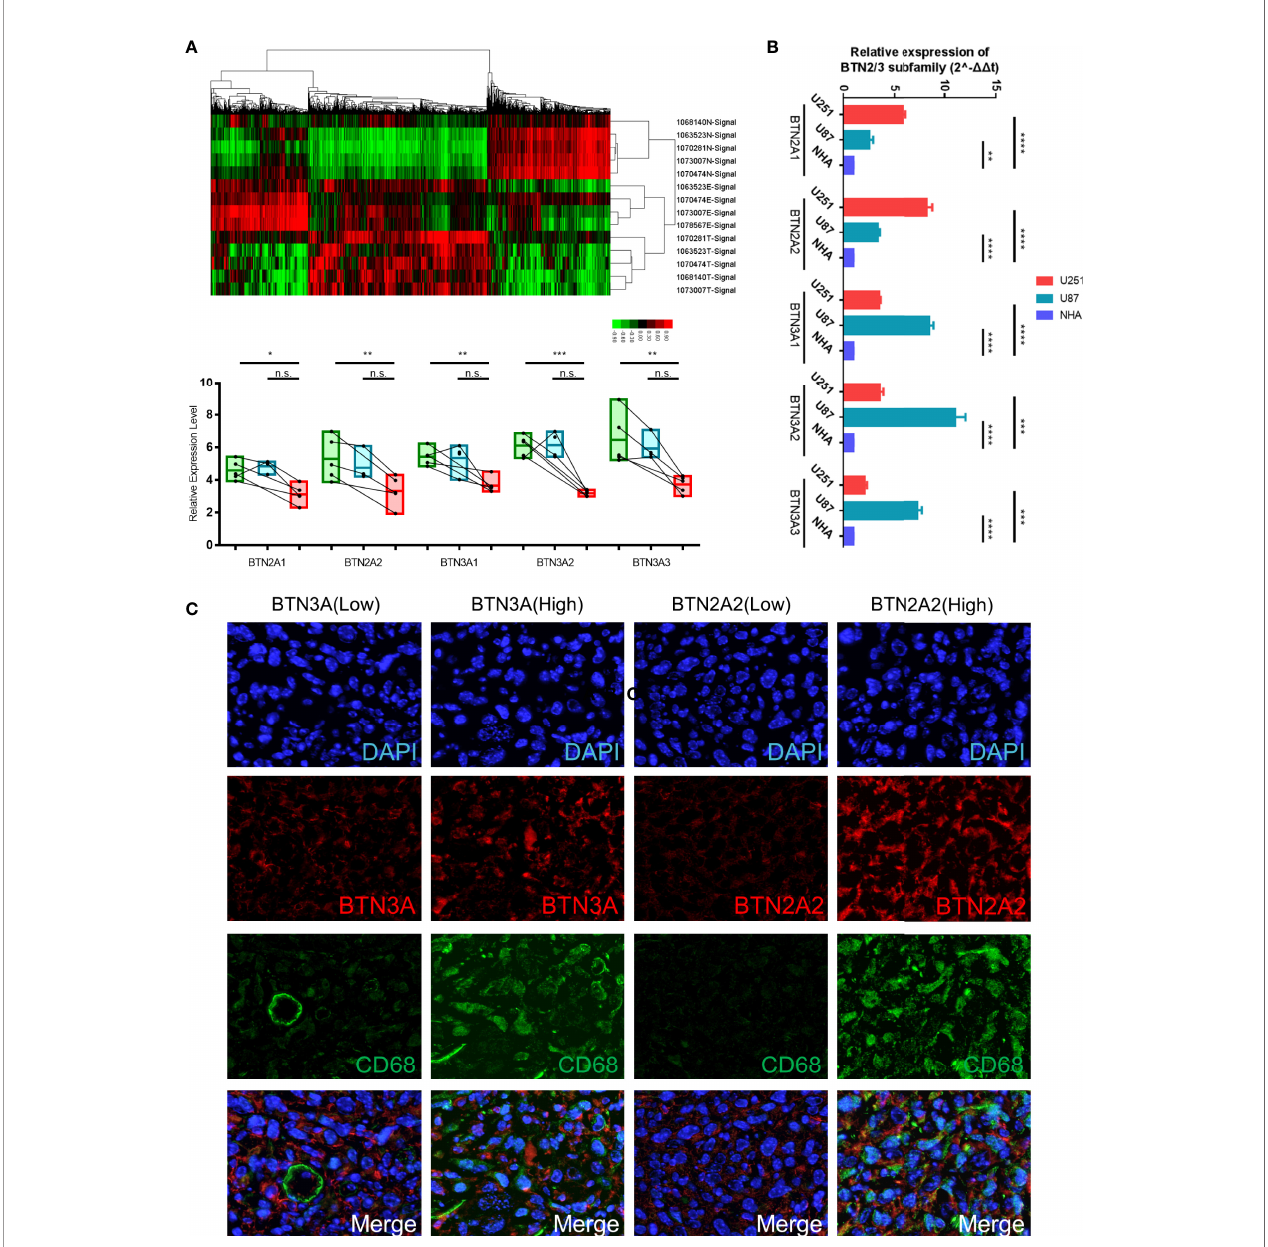
FIGURE 9 | Veri fi cation of BTN2/3 subfamily expression pro fi les and immune in fi ltration. (A) The differential expression clusters of PCGs in the glioma specimens and paracancerous tissues are shown. The suf fi x E-Signal represents edge tissues, the suf fi x T-Signal represents tumor tissues, and the suf fi x N-Signal represents normal tissues. The heatmap indicates the upregulated and downregulated PCGs. The expression levels of BTN2/3 subfamilies in the different tissues are displayed below. (B) The differential expression levels of BTN2/3 in the normal human astrocyte (NHA) cell line and GBM cell lines (U87 and U251). The results are presented as the mean ± SD from three independent experiments. (C) Results of immunohistochemical fl uorescence staining. According to the qRT-PCR results of BTN2A2 and BTN3A, the glioblastoma clinical samples were divided into high-/low-expression groups, and immunohistochemical fl uorescence staining was performed. Green signal, CD68, a panmacrophage biomarker; red signal, BTN2A2 or BTN3A, as presented in the fi gure; blue signal, DAPI. PCGs, protein-coding genes. *P < 0.05; **P < 0.01; ***P < 0.001; ****P < 0.0001; ns, no signi fi